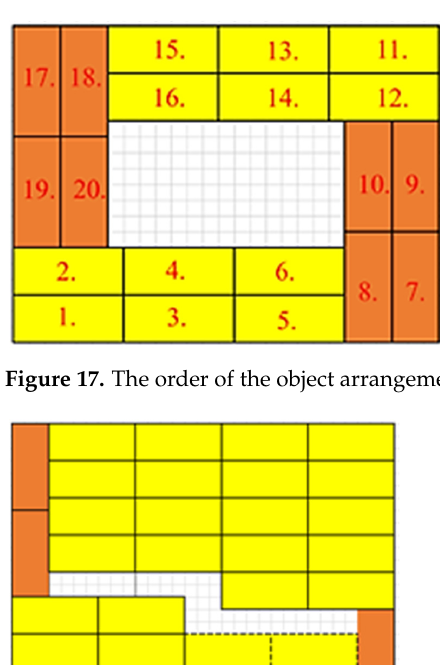
Algorithm 3. Horizontal overlap coordinate calculation